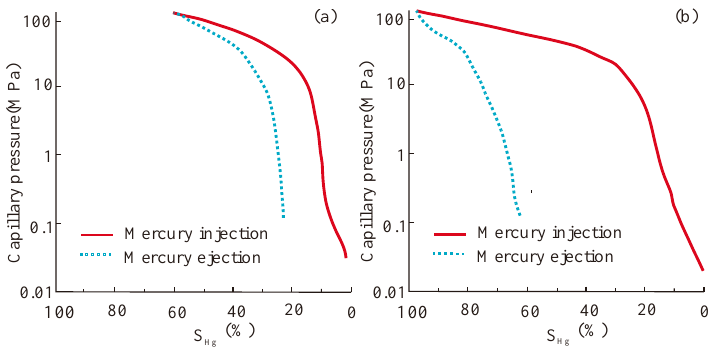
Figure 3. Capillary pressure curves of coal samples: ( a ) vitrain; ( b ) durain. Table 3. Pore characteristics of vitrain and durain samples.